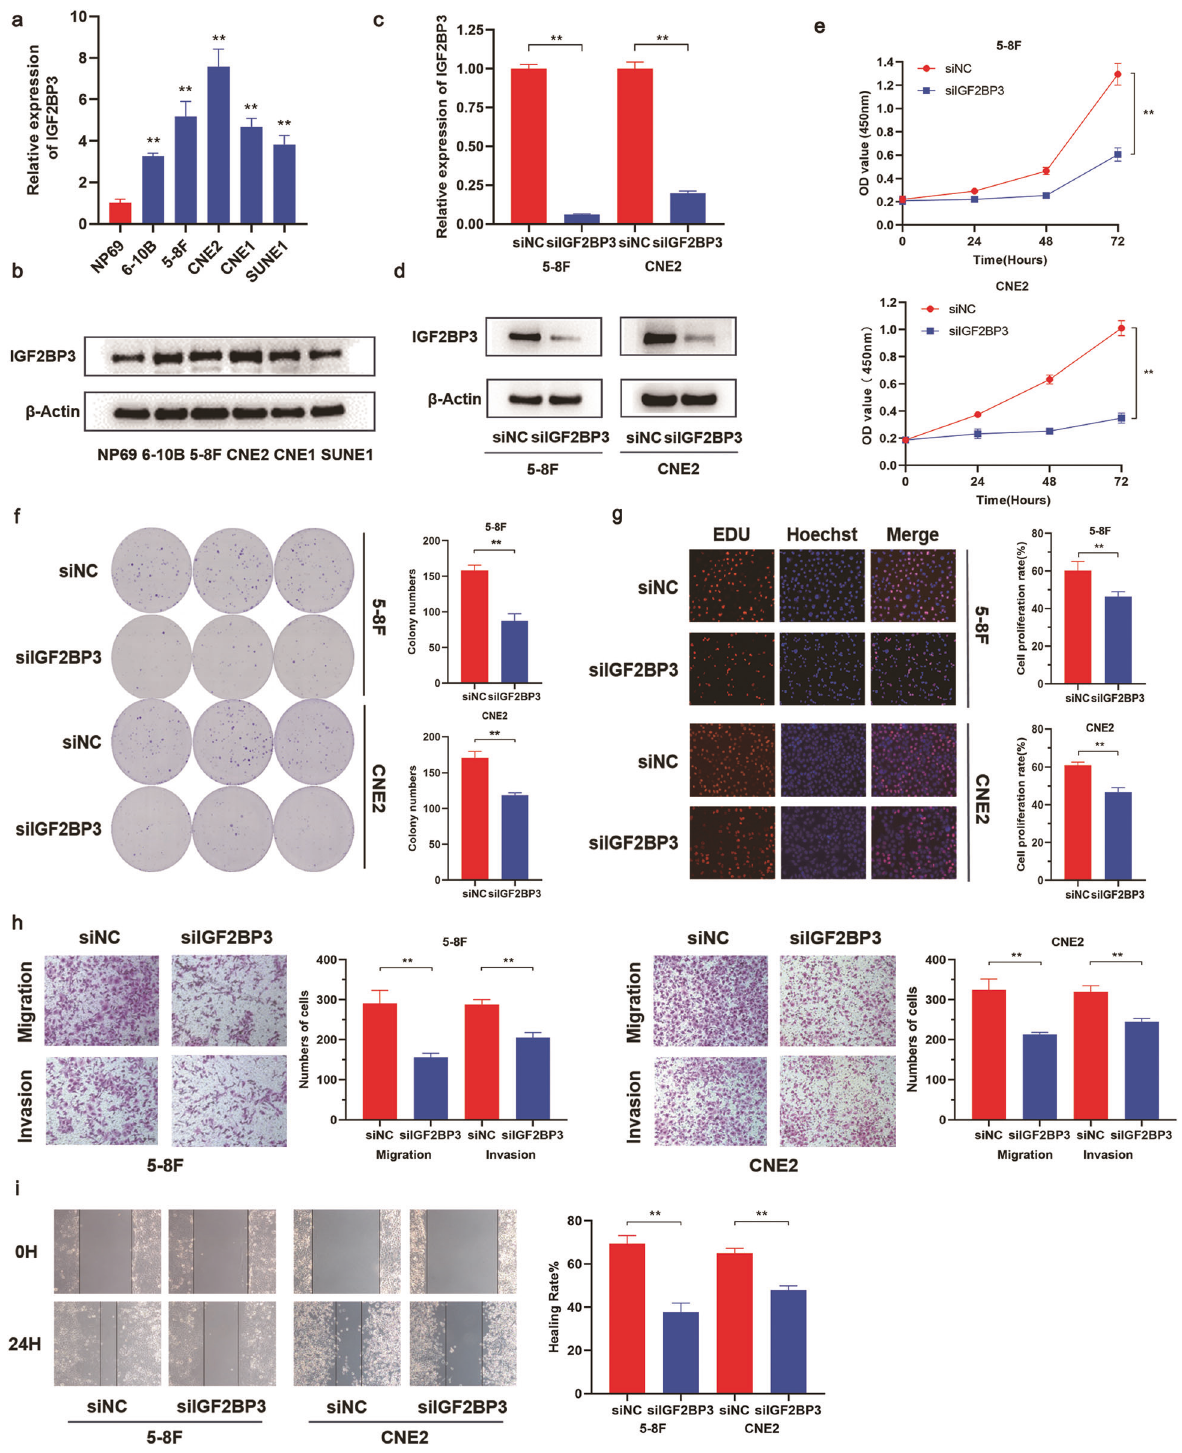
Fig. 2 IGF2BP3 is upregulated in NPC cells and promotes proliferation and metastasis. a , b The mRNA and protein expression of IGF2BP3 in human nasopharyngeal epithelial cell line and 5 NPC cell lines. c , d The expression of IGF2BP3 in NPC cells after transfection with siNC and siIGF2BP3. e – i CCK8 ( e ), colony formation assays ( f ), EDU assays ( g ), transwell assays ( h ), and wound healing assays ( i ) of IGF2BP3 knockdown on cell proliferation, migration and invasion. Data was shown as the mean ± standard deviation of three independent experiments. ** P < 0.01. IGF2BP3 regulates biological functions of NPC cells through negative control (Fig. 4k). We knocked down IGF2BP3 expression in KPNA2 Me-RIP assays given that silencing IGF2BP3 signi fi cantly decreased Rescue experiments were conducted to better explore whether KPNA2 mRNA enrichment (Fig. 4l). In summary, our data illustrated IGF2BP3 facilitated cell proliferation, invasion, and migration. Based that m6A “ reader ” IGF2BP3 impacts KPNA2 mRNA stability in an on the data of CCK8 assays, knocking down KPNA2 signi fi cantly m6A-dependent manner. Cell Death Discovery (2022)